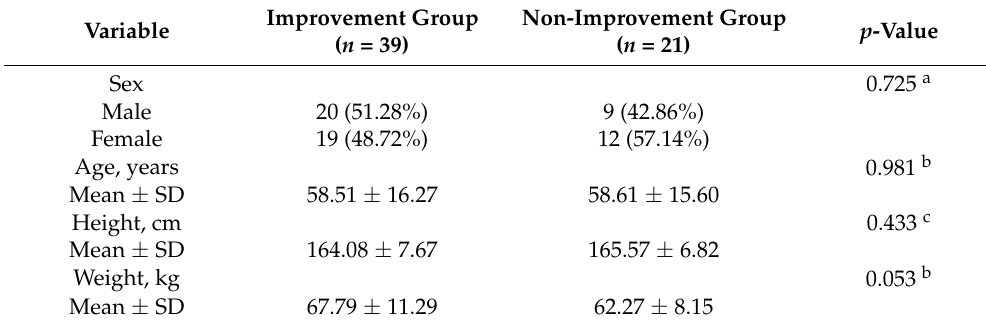
Table 1. Demographic data. Variable